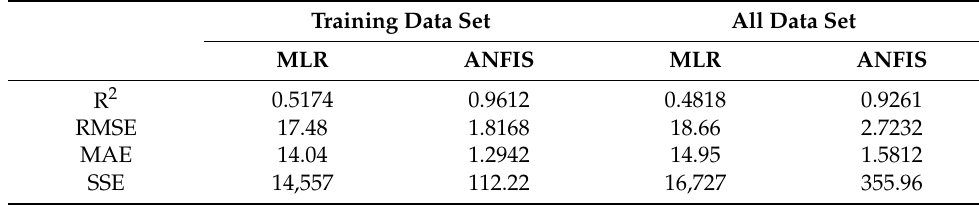
Table 5. Comparison of statistically criteria of models.